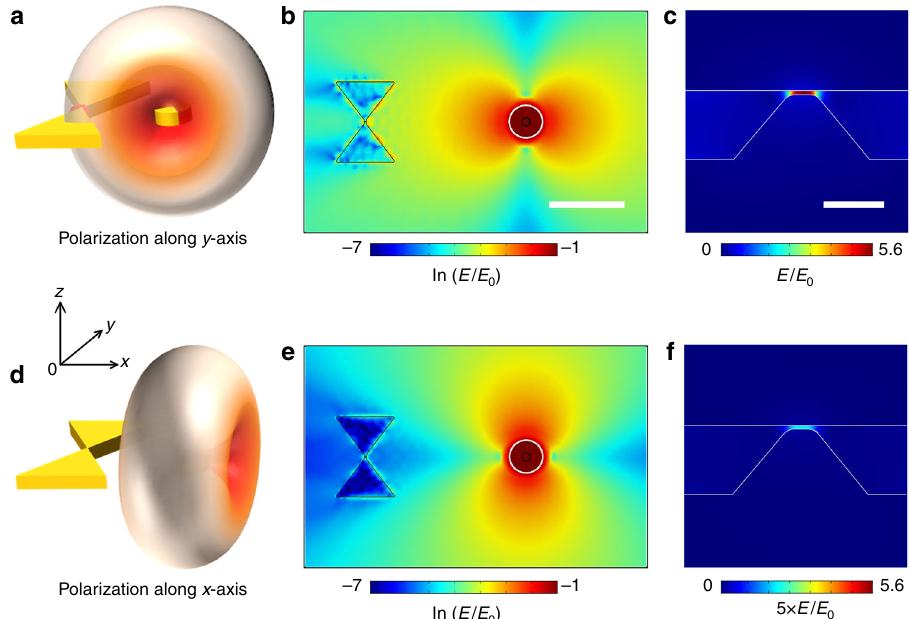
Fig. 3 Numerical simulations of the polarization dependence of the wireless power transfer. a Schematic of the operation principle of the wireless link. The rectenna is modeled as two Au triangles separated by a 0.5 nm gap. The optical antenna is a 220 nm Au antenna located 4 μ m to the right of the rectenna (black circle). When the transmitting antenna is illuminated with a laser polarized along y -axis, the dipolar radiation is directed towards the receiving antenna. b Calculated distribution of the electric fi eld, plotted in logarithmic scale, for an incident polarization along y -direction. The white circle indicates the size of the excitation in the form of a focused Gaussian beam where the focal spot is considered to be 600 nm in diameter. Scale bar is 2 μ m. c Zoomed image of the electric fi eld distribution present at the feed-gap of the rectenna. Scale bar is 10 nm. d Same con fi guration with an incident polarization along x -axis. The disc radiates in the orthogonal direction and hence the rectenna receives minimum amount of the transmitted energy. e and f are the electric fi eld maps for an incident polarization along the x -axis. For clarity, the electric fi eld in f is multiplied by a factor 5. The electric fi eld created at the gap decreases drastically when the signal emitted by the antenna is not directed toward the rectifying